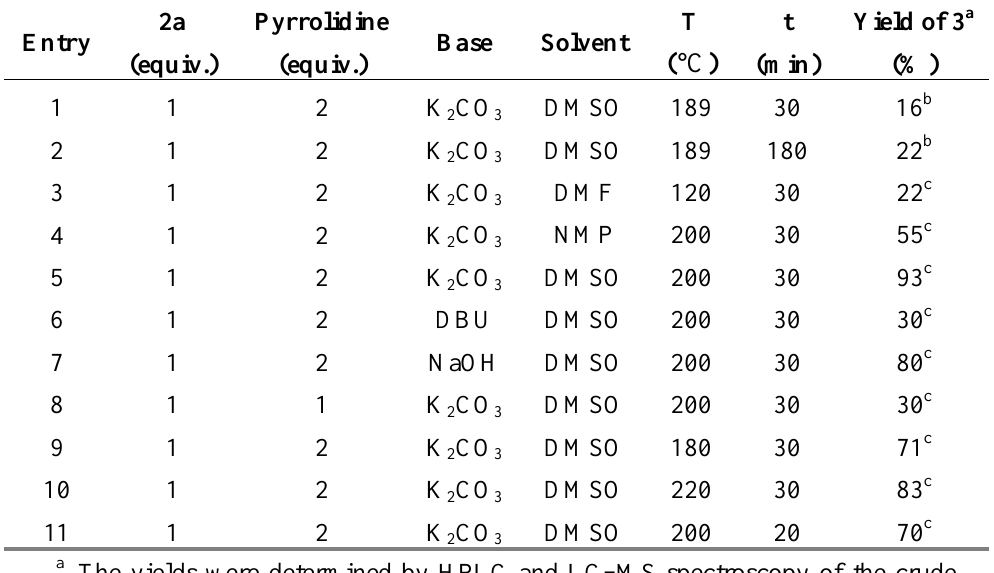
Table 1. Optimization of reaction